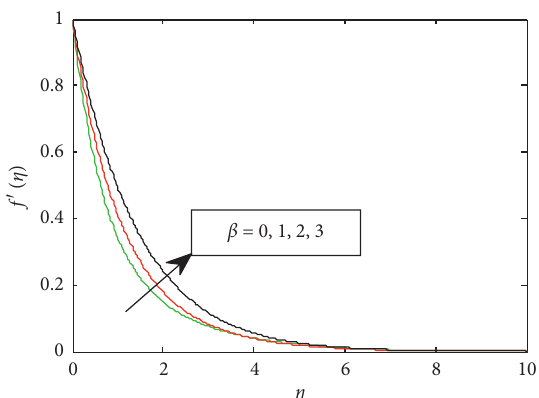
Figure 9: Velocity distribution for different values of material parameters.